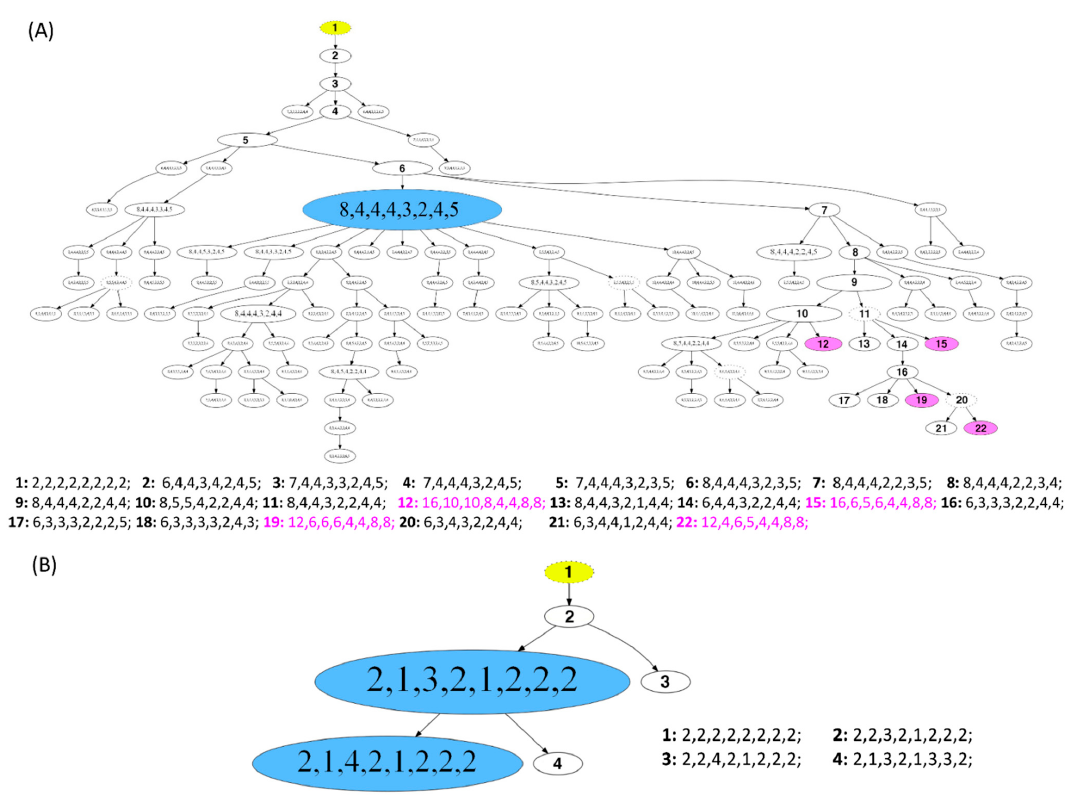
Figure 6. Phylogenetic trees of long survival cases ( A ) 5L and ( B ) 7L. The construction of the FISHtrees was done using phylogenetic algorithms (software FISHtrees 3.2) in the ploidyless mode. FISH patterns are depicted in the following gene order COX2 , DBC2 , MYC , CCND1 , CDH1 , TP53 , HER2 , ZNF217 . The FISHtrees results show the clonal evolution by generating a tree model starting from a normal state root labeled in yellow color (2-2-2-2-2-2-2-2) continuing by heuristically seeking to minimize the total number of CNAs across the tree. The size of the nodes reflects, but is not proportional to, the frequency of the patterns in the cell population. Nodes encircled by a solid line reflects miFISH-signal-patterns observed in the tumor sample. The FISHtrees algorithm predicts transit signal-patterns that are not observed in the sample so that in the evolution tree generated by the algorithm the up and downstream nodes can be linked. Those transit patterns are represented by nodes encircled with a dashed line. Details of the analysis are described in Section 2. ( A ) The blue labeled node indicates the presence of the tetraploid major clone (pattern 8-4-4-4-3-2-4-5; consisting of 71 out of 250 analyzed nuclei). Detailed signal patterns for selected clones (1–22) are displayed in the legend. In 4 clones, whole genome duplication events occur, marked in pink color with the numbering 12, 15, 19 and 22 (patterns: 16-10-10-8-4-4-8-8; 16-6-5-6-4-4-8-8; 12-6-6-6-4-4-8-8; 12-4-6-5-4-4-8-8). ( B ) The blue labeled nodes indicate the presence of the major clone with the most common pattern (2-1-3-2-1-2-2-2; consisting of 217 out of 250 analyzed nuclei) and the clone with the second most common pattern (2-1-4-2-1-2-2-2; consisting of 29 out of 250 analyzed nuclei). Detailed signal patterns for selected clones (1–4) are displayed in the